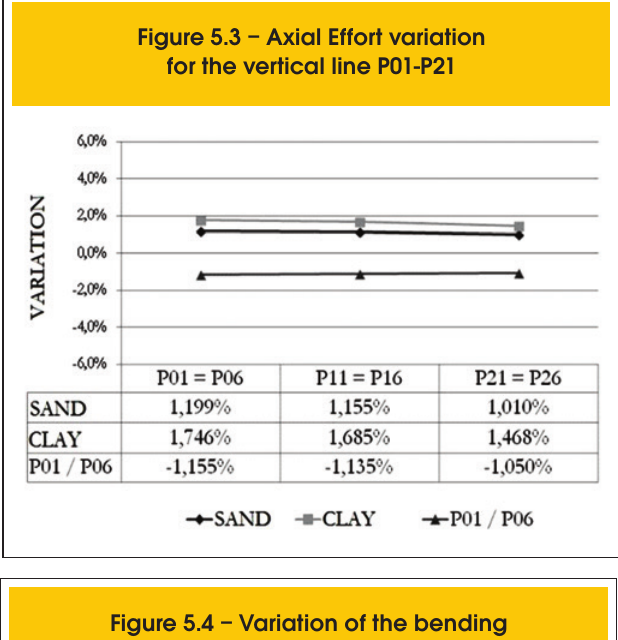
Figure 5.4 – Variation of the bending moment (MZ) for the vertical line P01-P21